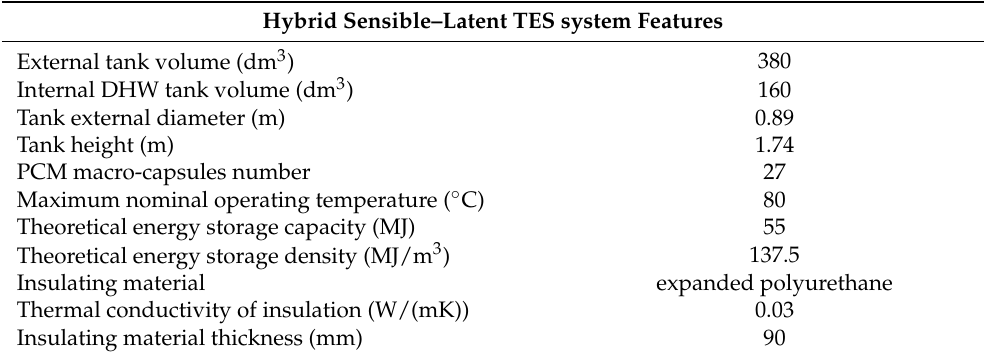
Figure 1. Detailed representation of the designed hybrid TES system: ( a ) 3D view of the internal structure, highlighting the PCM macro-capsules along the diameter and the internal spiral HEX; ( b ) 2D section of the hybrid tank, with the different hydraulic connections and the internal tank inserted; ( c ) overall exploded 3D view with the different components highlighted. Table 2. Main features of the designed hybrid TES